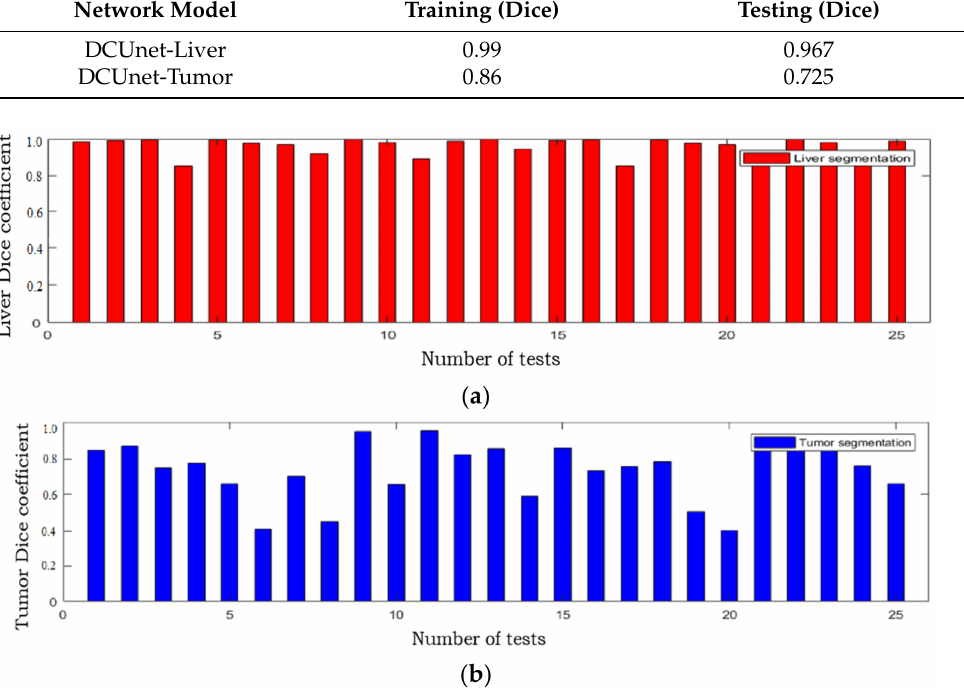
Figure 8. The Dice coefficient of the segmentation results of the proposed algorithm in the test set on 25 CT sequence images: ( a ) Dice coefficient of the liver segmentation results; ( b ) Dice coefficient of the tumor segmentation